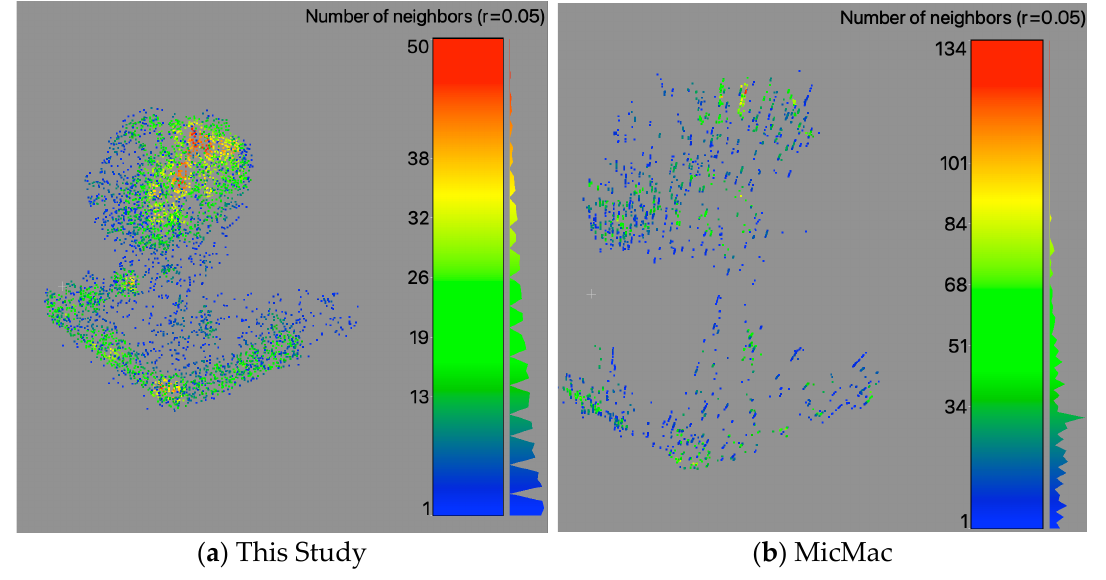
Figure 13. Density evaluation of a small shift on the reconstruction in CloudCompare.